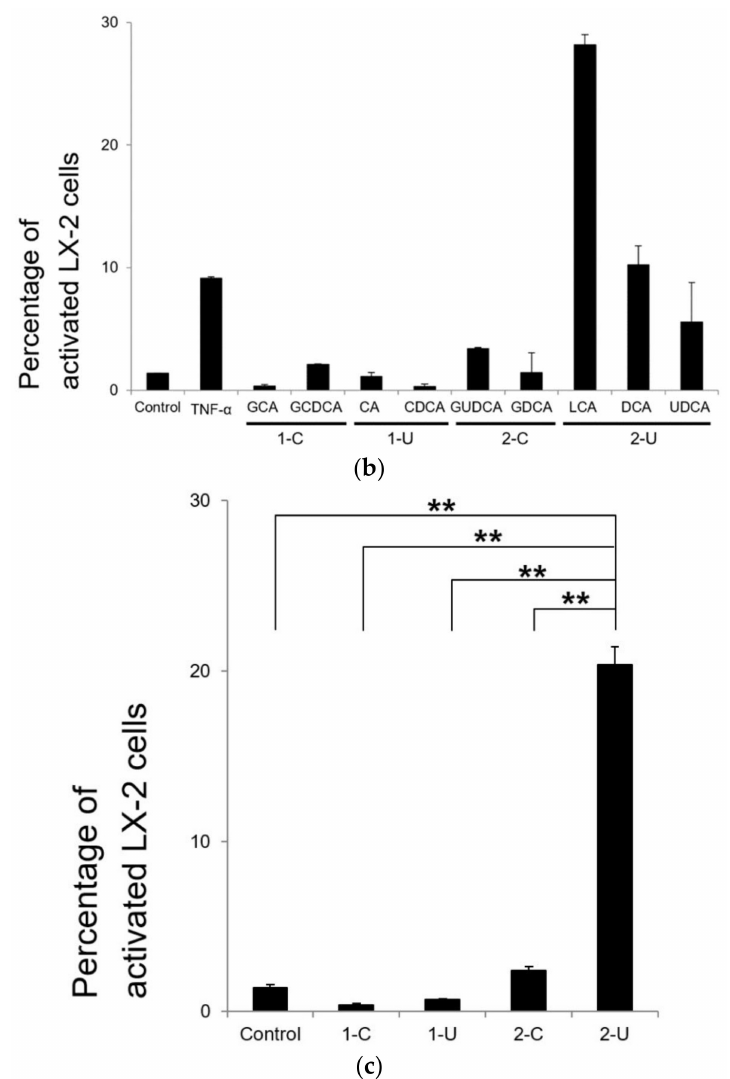
Figure 7. Activation of LX-2 cells. ( a ) Representative plots of α -smooth muscle actin ( α -SMA) in LX-2 cells cultured with or without 10 ng/mL TNF- α and various BAs at a concentration of 500 µ M for 48 h that were analyzed using flow cytometry. Gating was performed using the group without the primary antibody (1stAb( − )) as control. Hepatic stellate cell (HSC) population was analyzed by α -SMA (x-axis) and side scatter (y-axis). ( b ) Percentages of activated HSCs with high expression of α -SMA cultured with various bile acids were measured using flow cytometry. Data are expressed as the mean ± SD of 5–7 separate experiments. 1-C, primary conjugated BAs; 1-U, primary unconjugated BAs; 2-C, secondary conjugated BAs; 2-U, secondary unconjugated BAs. ( c ) Percentages of activated HSCs averaged per BA treatment group. Data are expressed as the mean ± SD. Comparisons of different LX-2 cell treatments were carried out using one-way analysis of variance followed by Bonferroni’s correction (** p <